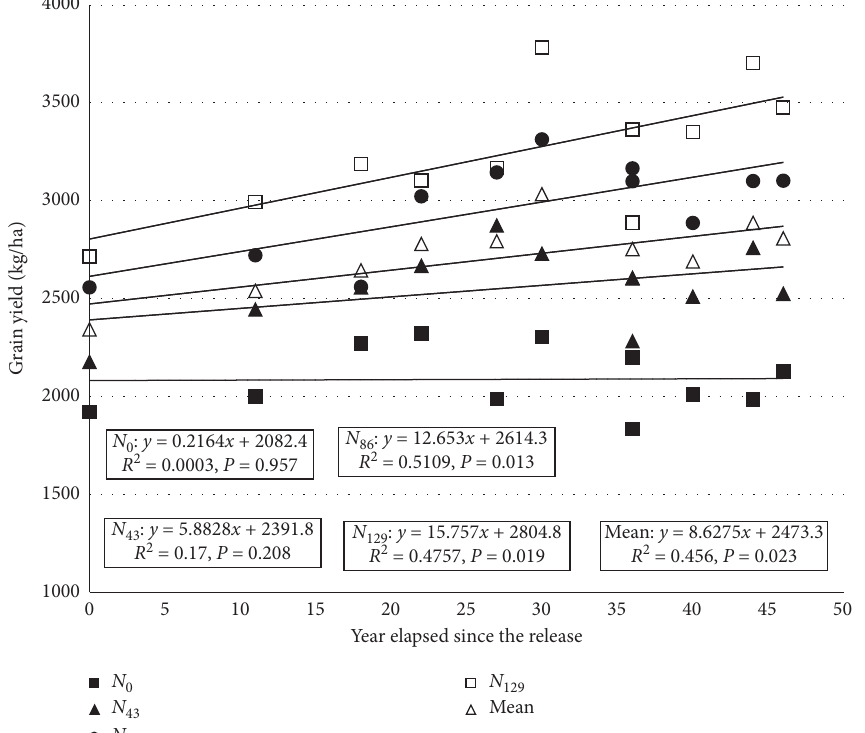
Figure 2: Relationship of grain yield (kg ha − 1 ) of 11 bread wheat cultivars released between 1960 and 2006 and grown at four N levels with the time elapsed since their year of